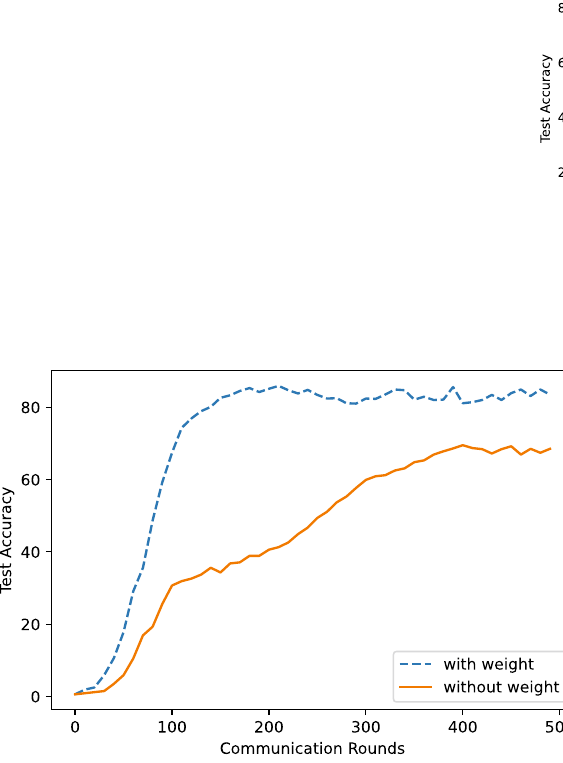
Fig. 6 The proposed